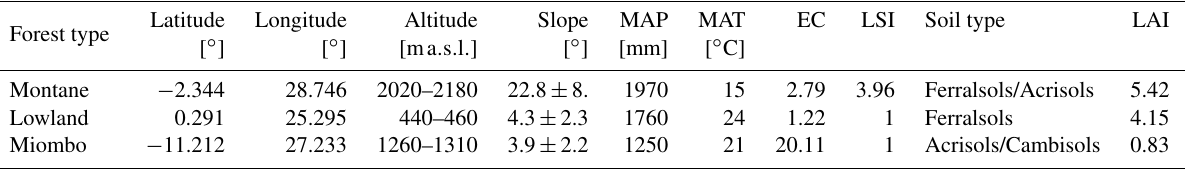
Table 1. Site characteristics of the three forest types. The range of altitudes of the sampled profiles and topsoil samples is shown. The slope indicates the average slope ± standard deviation from all the samples taken at the respective forest site. MAP is the mean annual precipitation, and MAT is the mean annual temperature extracted from the WorldClim database (average MAP for the years 2010–2018). EC represents the mean erosion coefficient values calculated from Eq. (1). LSI is the landslide hazard risk for each site extracted from the Global Landslide Hazard Map (Worldbank). LAI is the mean annual leaf area index, extracted from the Copernicus LAI 300m database (European Environment